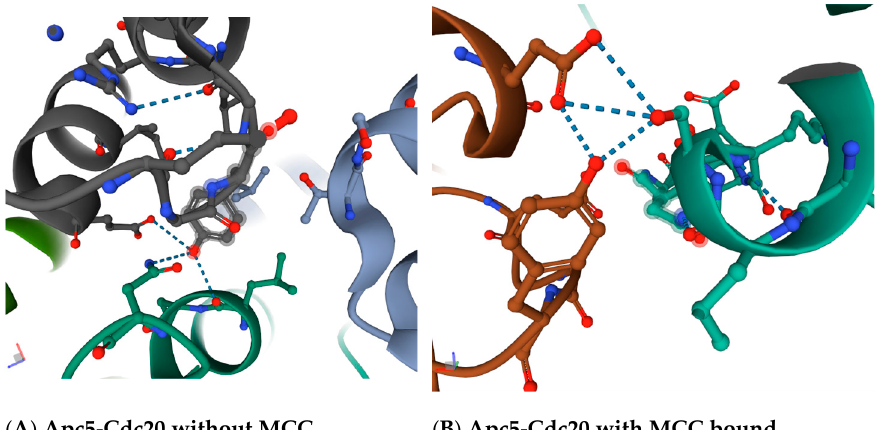
Figure 3. Proposed interaction sites between amino acid residues in human Apc5 and human Cdc20. ( A ) The modeled interactions in the absence of the mitotic checkpoint complex (MCC) between tyrosine Y296 in Apc5 (displayed in charcoal gray) with leucine L95 and asparagine N99 in Cdc20 (displayed in dark green). Dashed blue-gray lines denote modeled interactions. ( B ) The modeled interactions in the presence of the mitotic checkpoint complex (MCC) between tyrosine Y296 in Apc5 (displayed in brown) and glutamic acid E333 in Apc5 (displayed in brown) with serine S96 in Cdc20 (shown in dark green). Dashed blue-gray lines denote modeled interactions. Images are from the RCSB PDB (rcsb.org) of PDB ID 6Q6G (without MCC) and PDB ID 6TLJ (with MCC bound) [4,31,32].